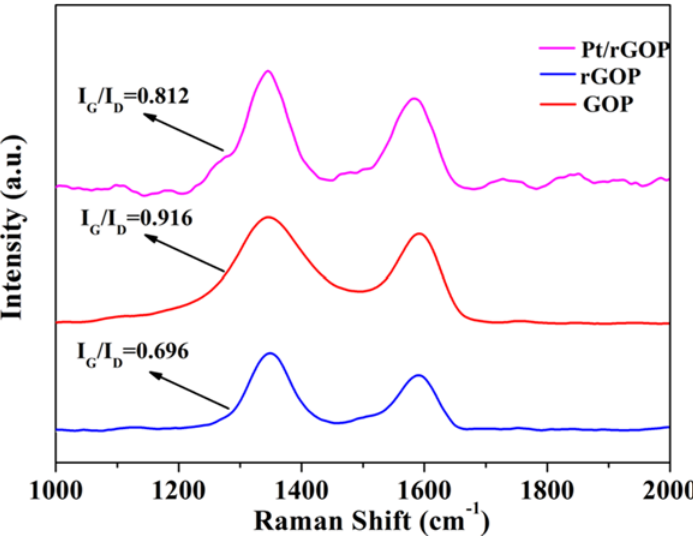
Figure 4. Raman spectra of GOP, rGOP and Pt/rGOP.